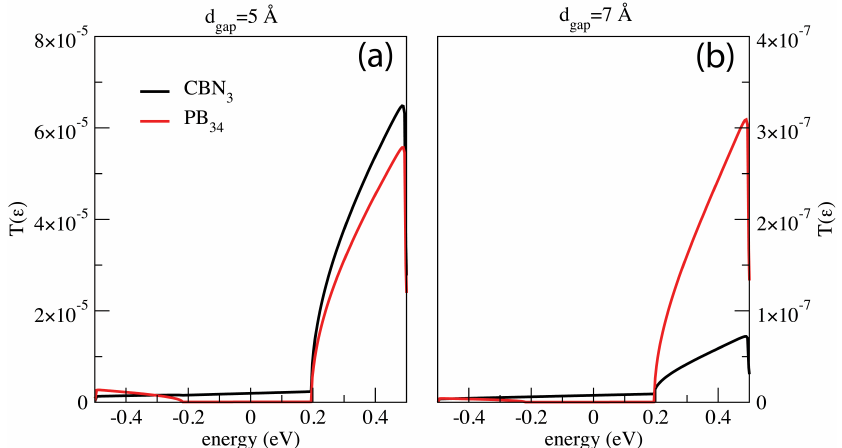
Figure 5. Transmission functions related to the configurations CNB 3 and PB 34 for two different gap size: 5 Å ( a ) and 7 Å ( b ). In both the cases, the states that contributes most to the transport are the ones in the energy range [0.2 eV ≤ (cid:101) ≤ 0.5 eV]. The gap size affects the transmission function hierarchy: for the widest gap ( b ) the transmission function hierarchy of the PB 34 and CNB 3 configurations is opposite to that obtained for the narrowest gap ( a